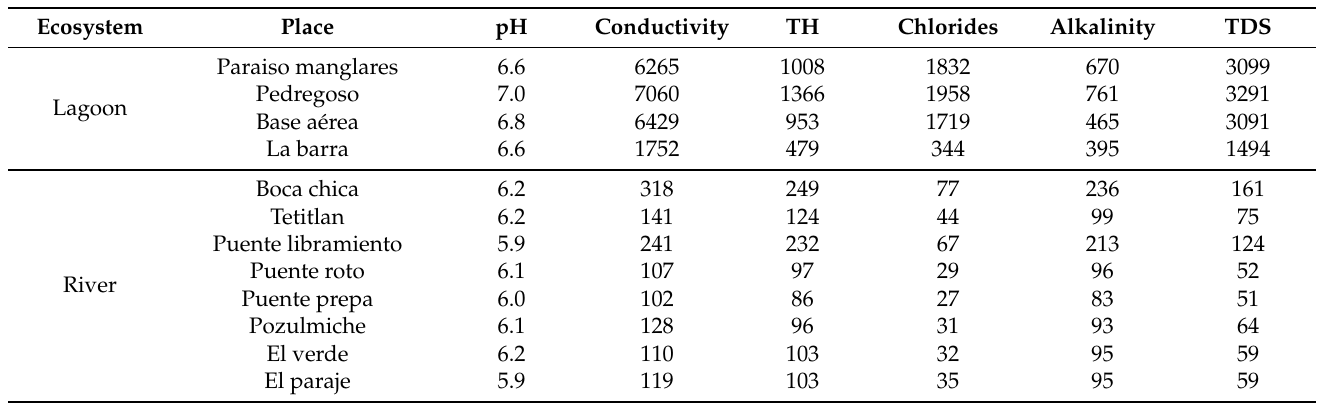
Table 4. Maximum permissible